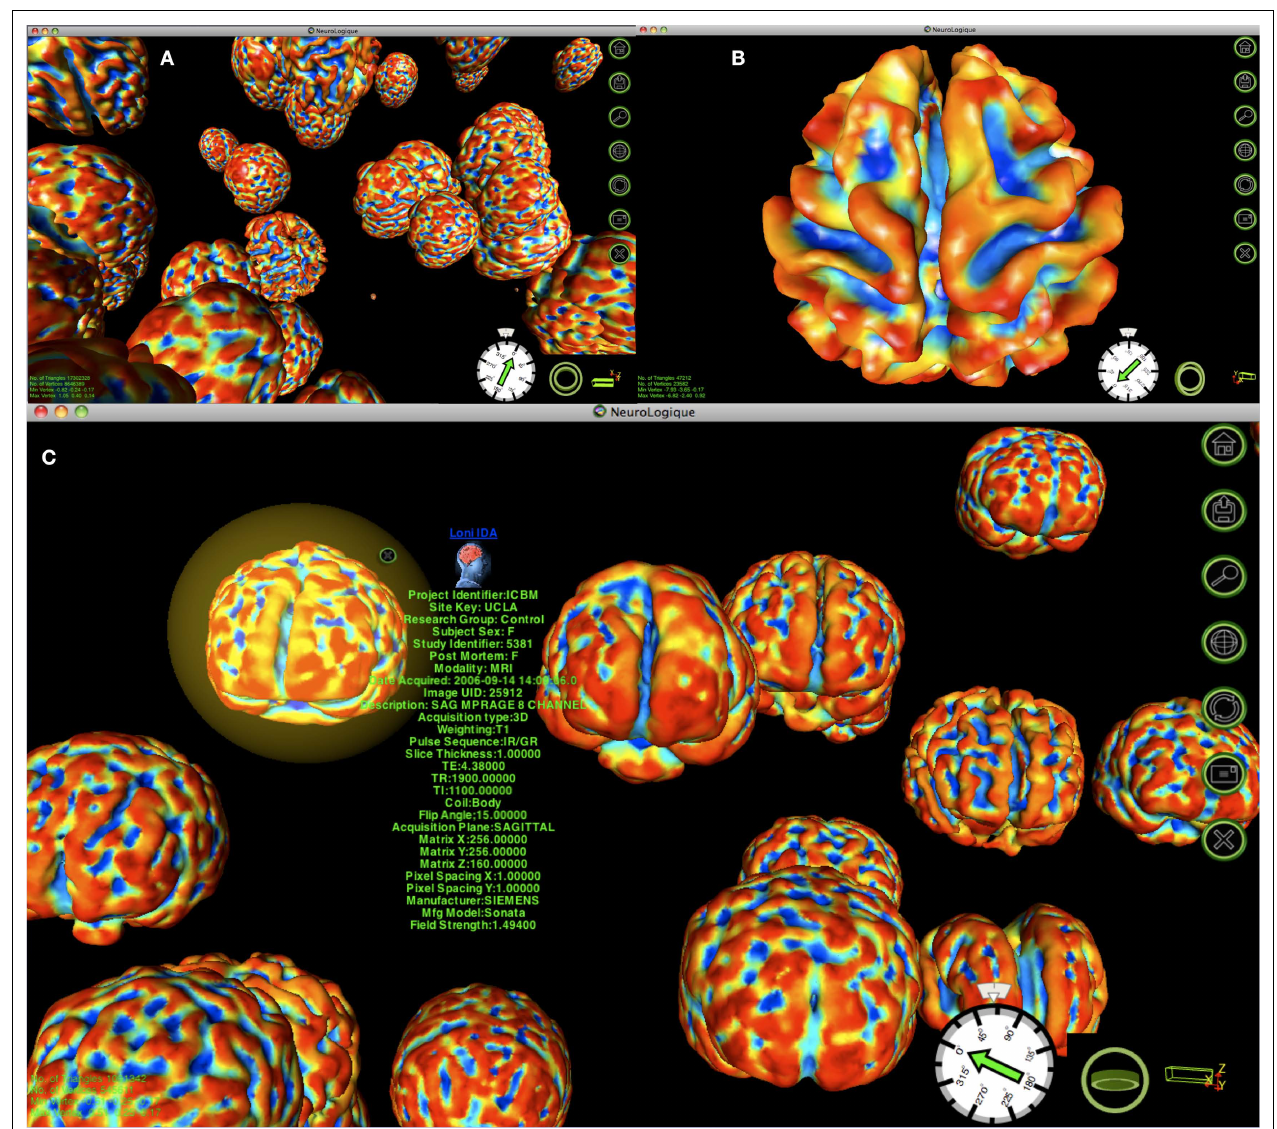
FIGURE 5 | A snapshot of the 3D Visualization environment for the neuro- meta-space displaying a group of brain surfaces from the ADNI 400 dataset. (A) A zoomed-in view of the 3D interface. (B) A close-up of an individual brain belonging to the AD category. (C) Alternate view of the interface with the meta-data (green text) displayed, as a result of a right-click action on one of the brains.